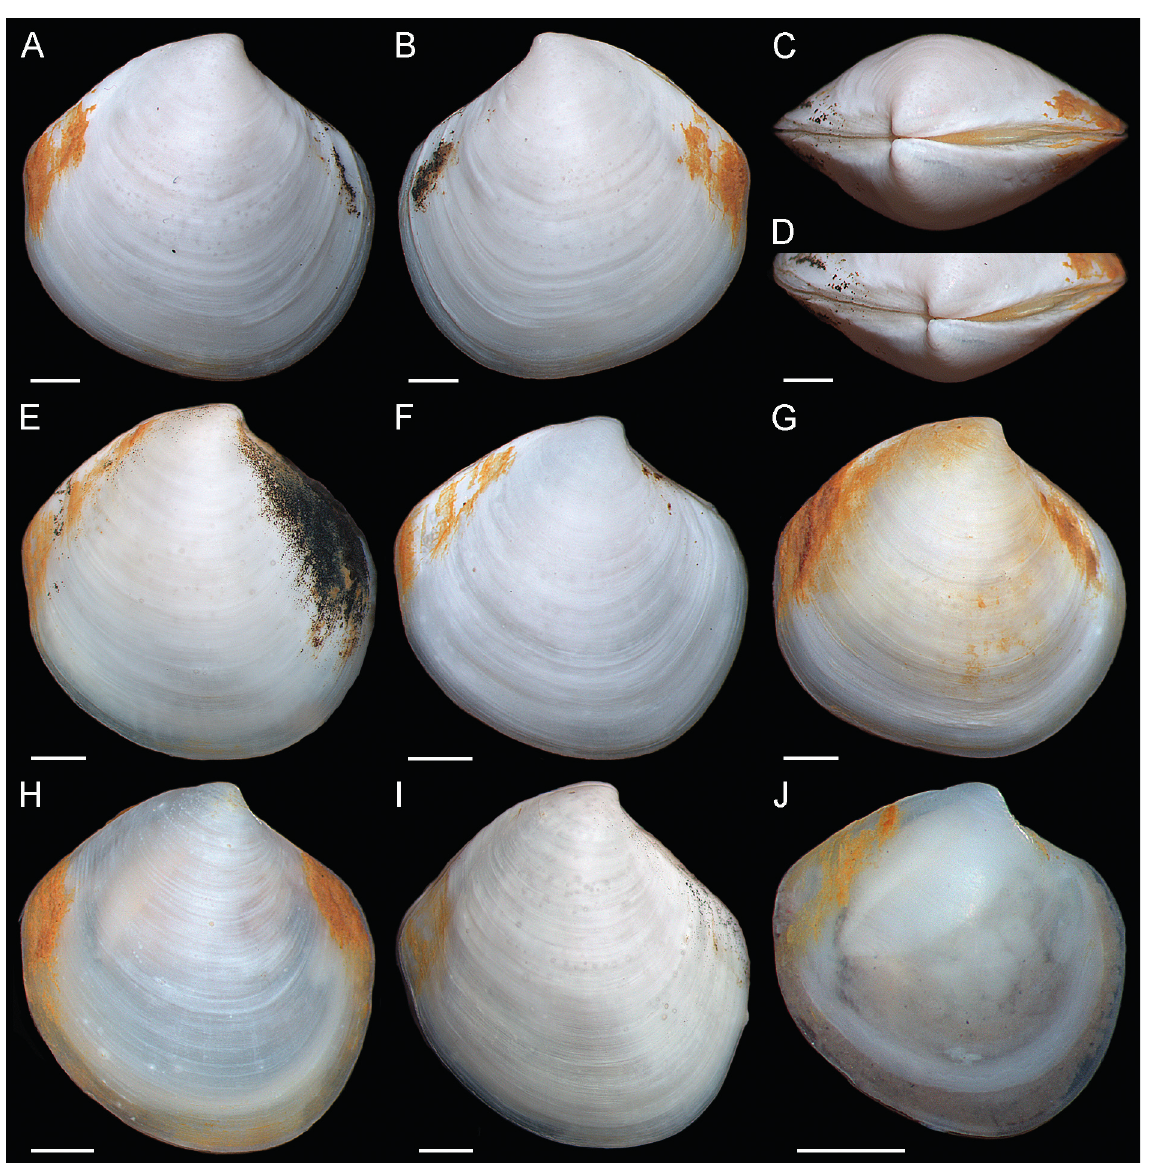
Fig 2. Parathyasira coani sp. nov. A–D . Holotype (MIMB 43813), exterior and dorsal views of both valves, shell length 7.1 mm. E . Paratype (SMF 367801), shell length 6.5 mm. F . Paratype (SMF 367801), shell length 5.8 mm. G–J . Variability of shell shape. G . Shell length 6.5 mm (MIMB 43819). H . Shell length 5.7 mm (MIMB 43819). I . Shell length 6.9 mm (MIMB 43816). J . Shell length 3.2 mm (MIMB 43820). Scale bars = 1